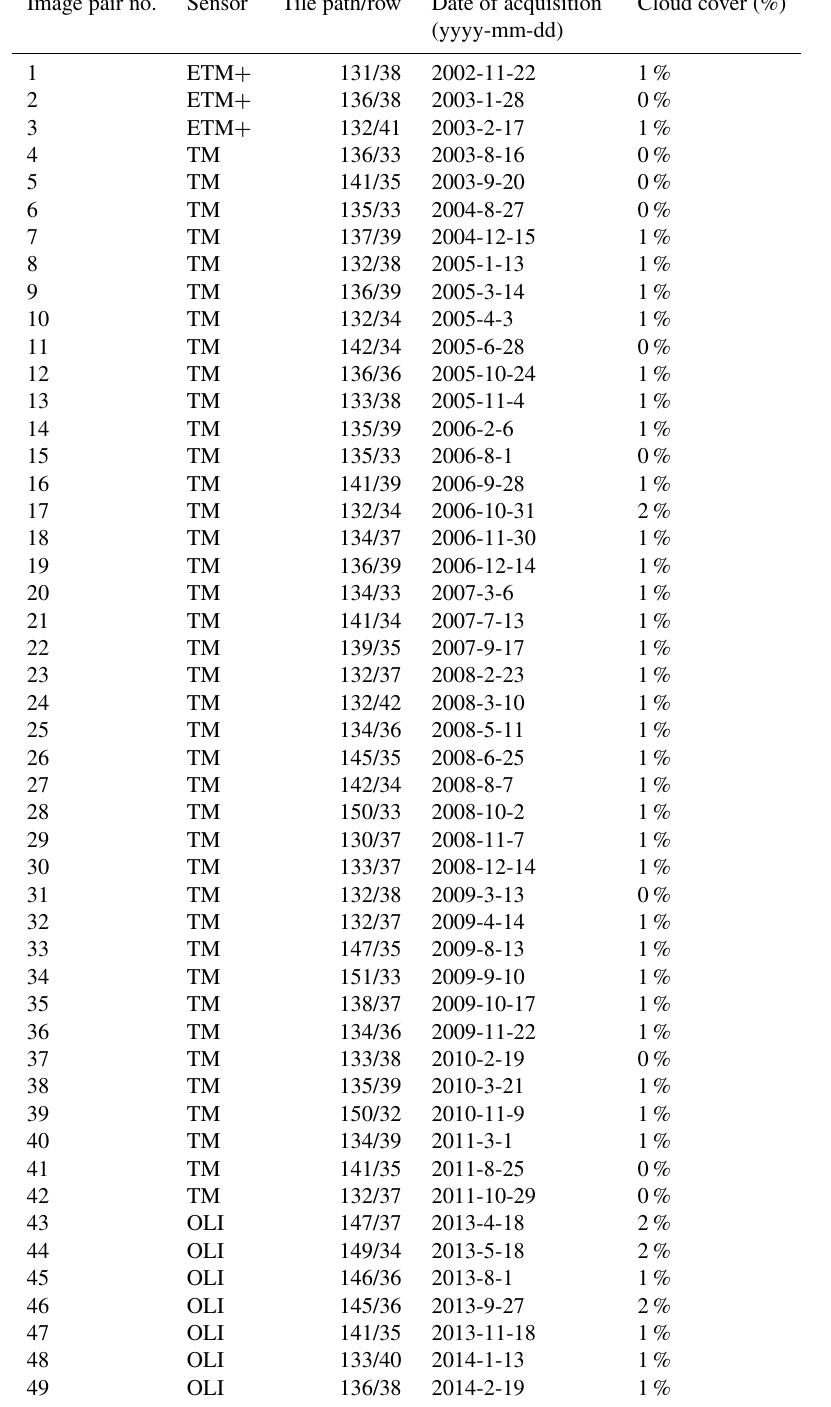
Table A1. Landsat series images used for assessment of the HMRF-based snow cover products in this study. Image pair